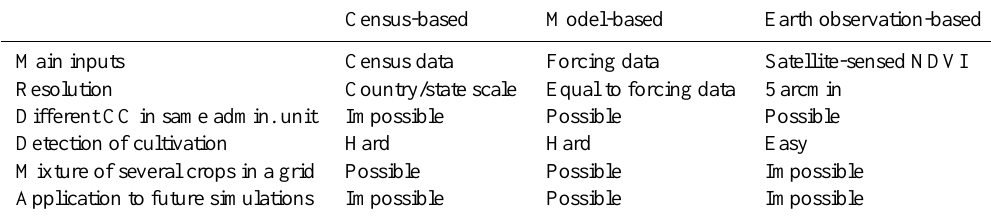
Table 6. Advantages and disadvantages of three types of global crop calendars: census-based, model-based, and Earth observation-based. Census-based Model-based Earth observation-based Main inputs Census data Forcing data Satellite-sensed NDVI Resolution Country/state scale Equal to forcing data 5arcmin Different CC in same admin. unit Impossible Possible Possible Detection of cultivation Hard Hard Easy Mixture of several crops in a grid Possible Possible Impossible Application to future simulations Impossible Possible